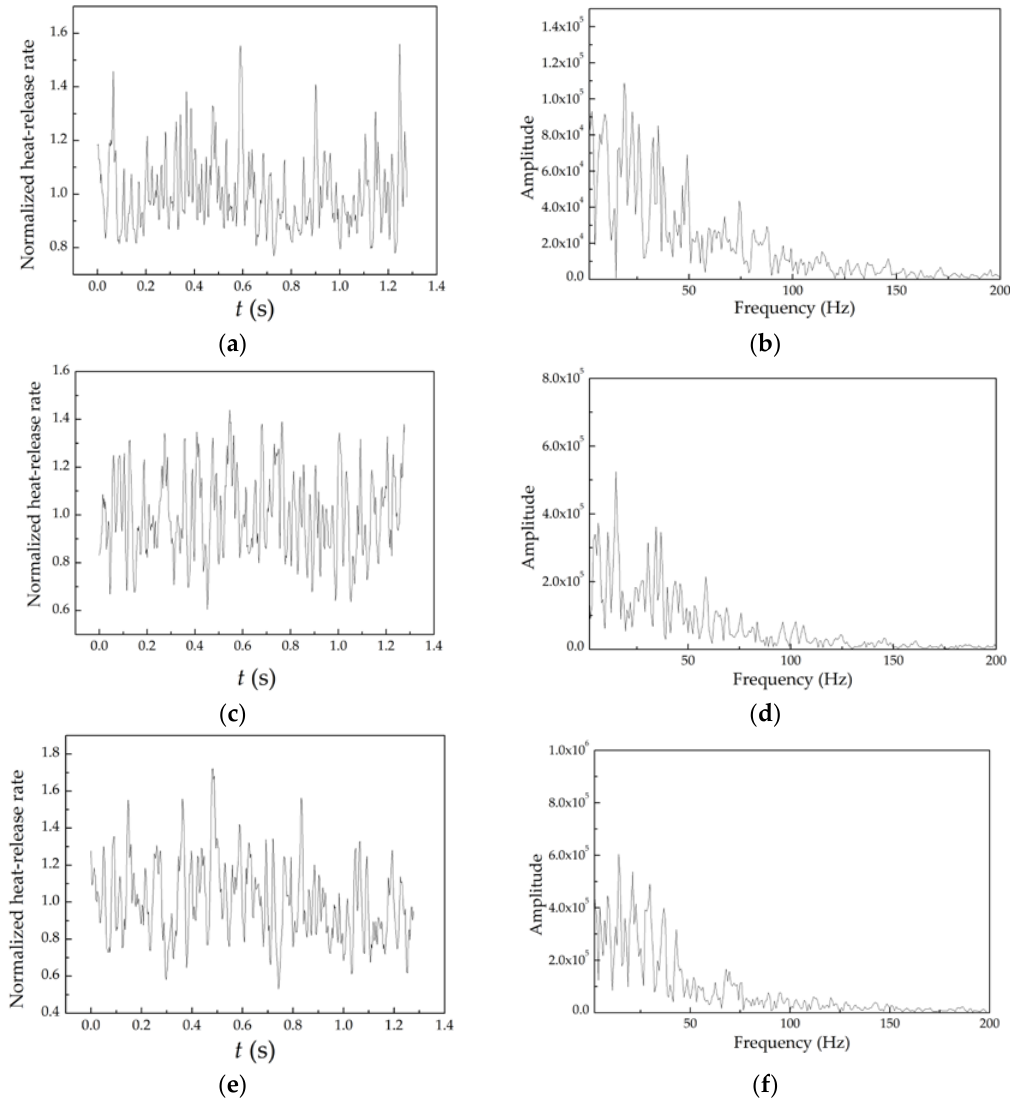
Figure 7. Flame heat-release rate pulsation curves and corresponding spectrum curves for combustor pressure: ( a ) pulsation curve at P = 3 bar; ( b ) spectrum curve at P = 3 bar; ( c ) pulsation curve at P = 4 bar; ( d ) spectrum curve at P = 4 bar; ( e ) pulsation curve at P = 5 bar; ( f ) spectrum curve at P = 5 bar.